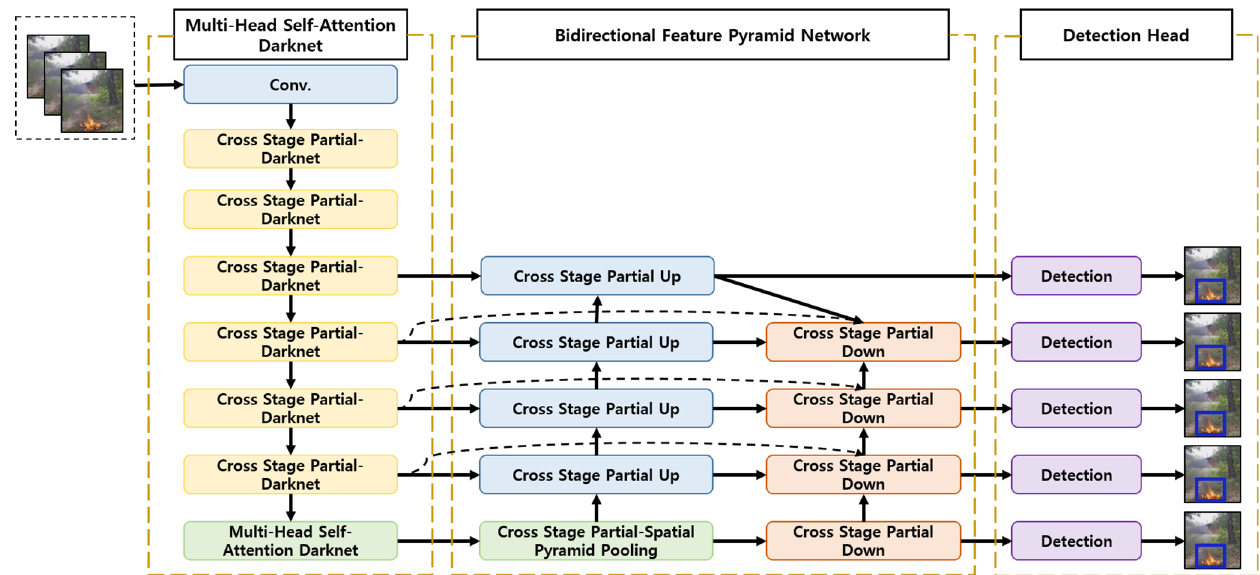
Figure 1. The architecture of the Vision Transformer ‐ based object detection model [14].